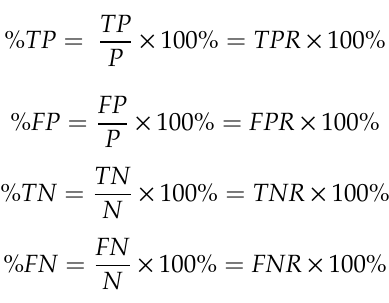
Table S2. The selected models were saved in PMML (Predictive Model Markup Language) format (http: // dmg.org / pmml / pmml-v3-0.html) and are available in the Supplementary Materials